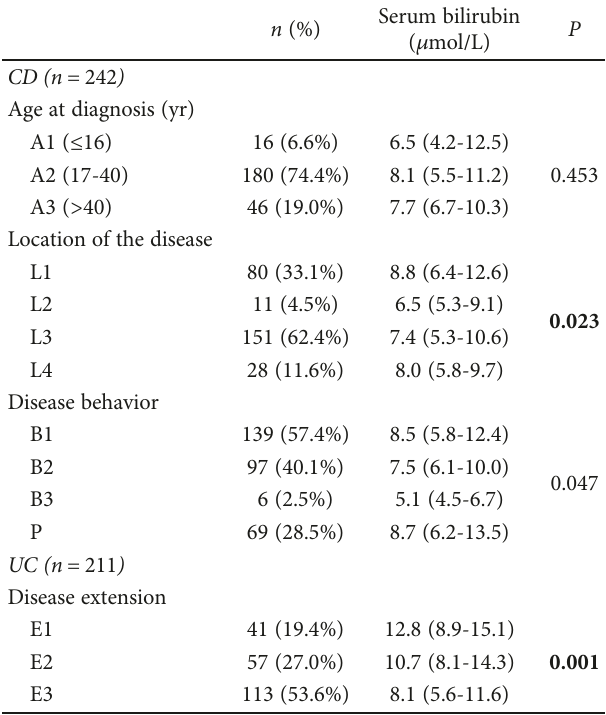
Table 3: Relationship between phenotype characteristics and serum bilirubin levels of patients with